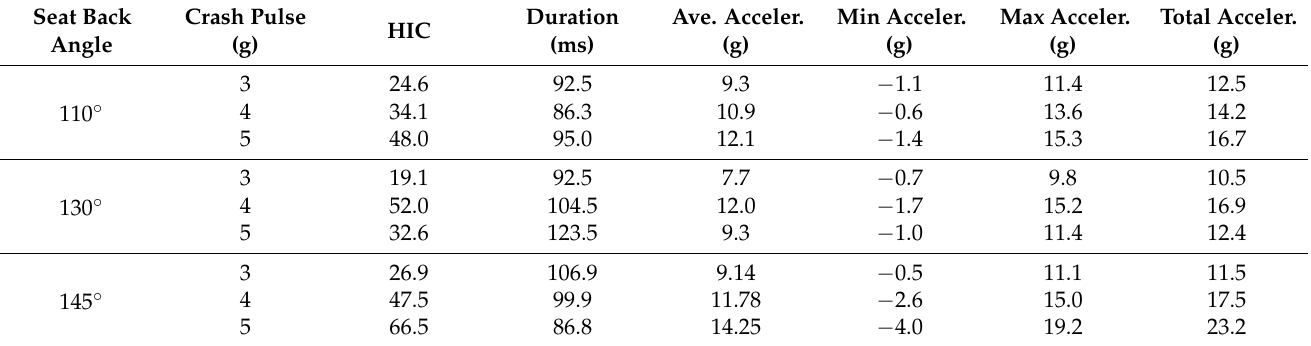
Table 2. The accelerations for all crash pulses as well as the acceleration peak duration and HIC.